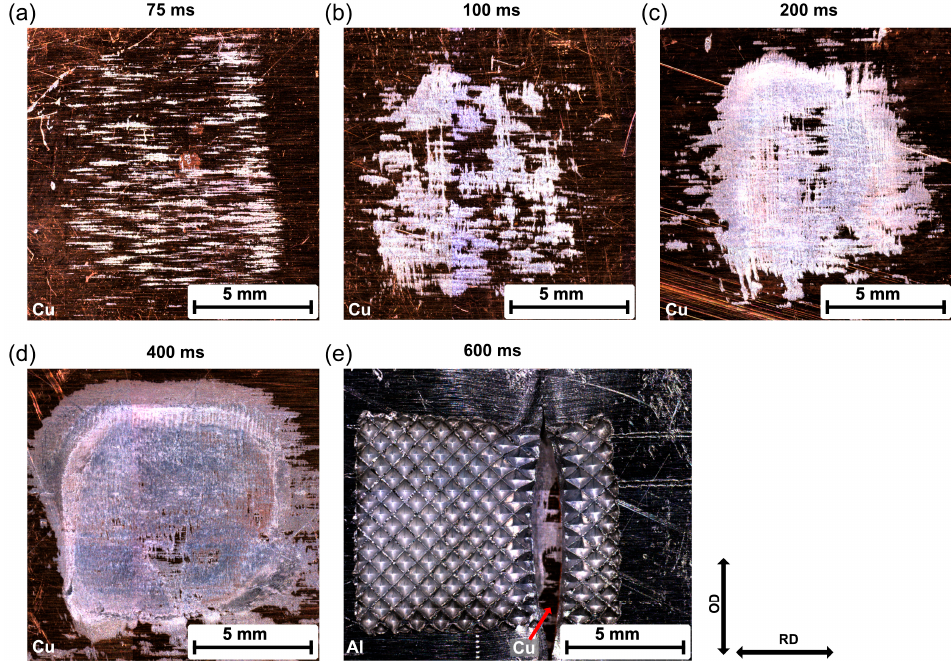
Figure 11. Fracture surfaces of Al–Cu joints after tensile shear tests: ( a ) 75 ms; ( b ) 100 ms; ( c ) 200 ms; ( d ) 400 ms; ( e ) 600 ms.